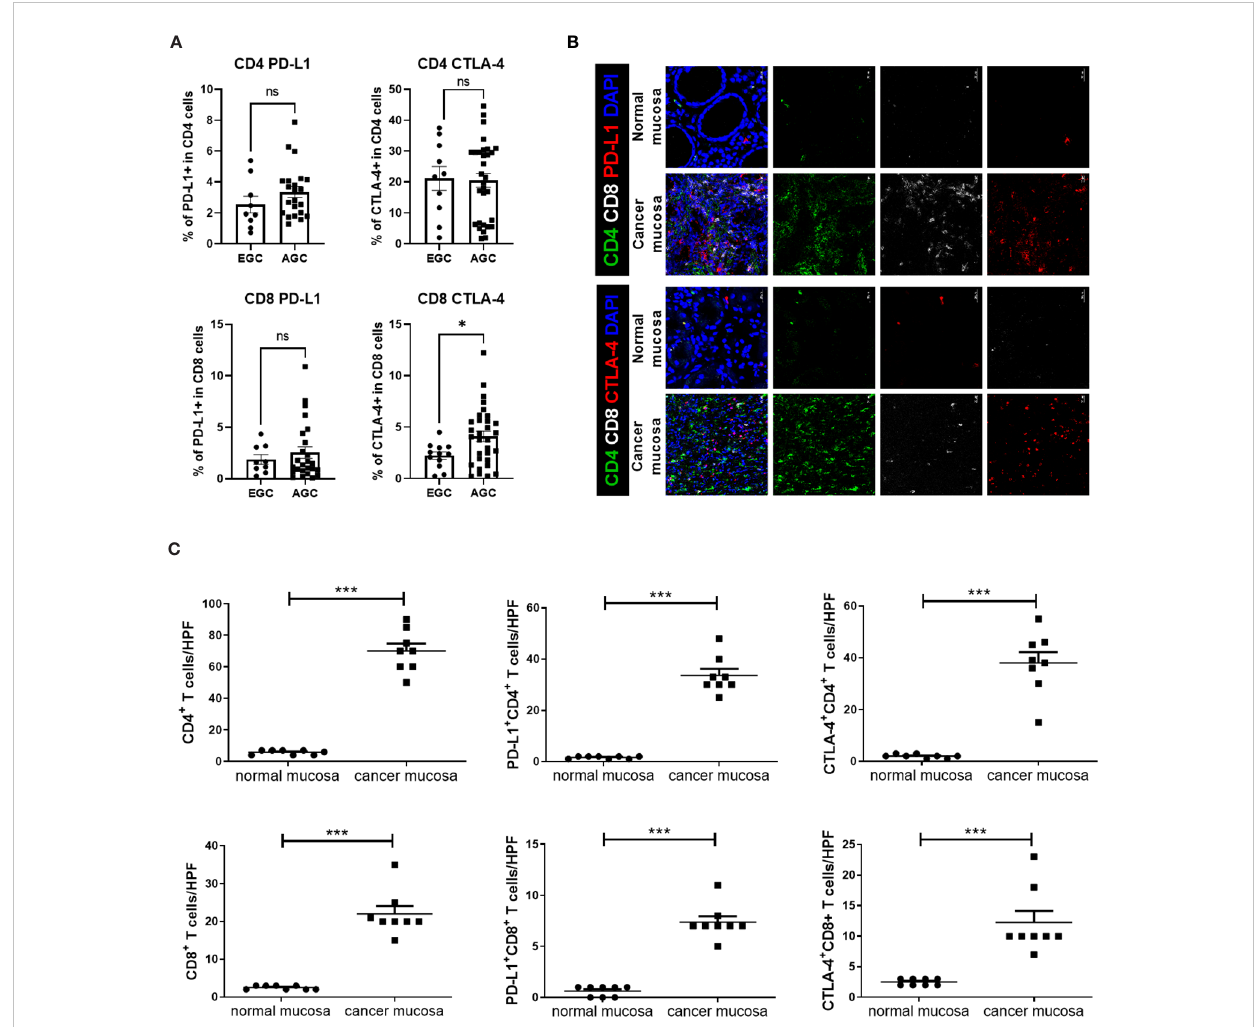
FIGURE 1 Expression levels of immunosuppressive markers, such as PD-L1 and CTLA-4, on T cells were higher in blood and cancer tissue from GC patients. Peripheral blood mononuclear cells from GC patients were stimulated with phorbol myristate acetate and ionomycin for 4 h, followed by GolgiStop for an additional 2 (h) Normal and cancer mucosa were harvested from GC patients, then stained with CD4+, CD8+, PD-L1, CTLA-4, and DAPI. (A) Bar graphs show percentages of PD-L1 + CD4 + T cells (top and left), CTLA-4 + CD4 + T cells (top and right), PD-L1 + CD8 + T cells (bottom and left), and CTLA-4 + CD8 + T cells (bottom and right) in peripheral blood mononuclear cells from early GC (EGC) and advanced GC (AGC) patients. (B) Representative confocal images showing PD-L1 + CD4 + , CTLA-4 + CD4 + , PD-L1 + CD8 + , and CTLA-4 + CD8 + T cells in normal (n = 8) and mucosa (n = 8) mucosa. (C) Bar graphs show mean number of cells per high-power fi eld (HPF) in normal and cancer mucosa. Scale bar = 20 m m. Data are means ± standard errors of the mean (* p < 0.05, *** p <